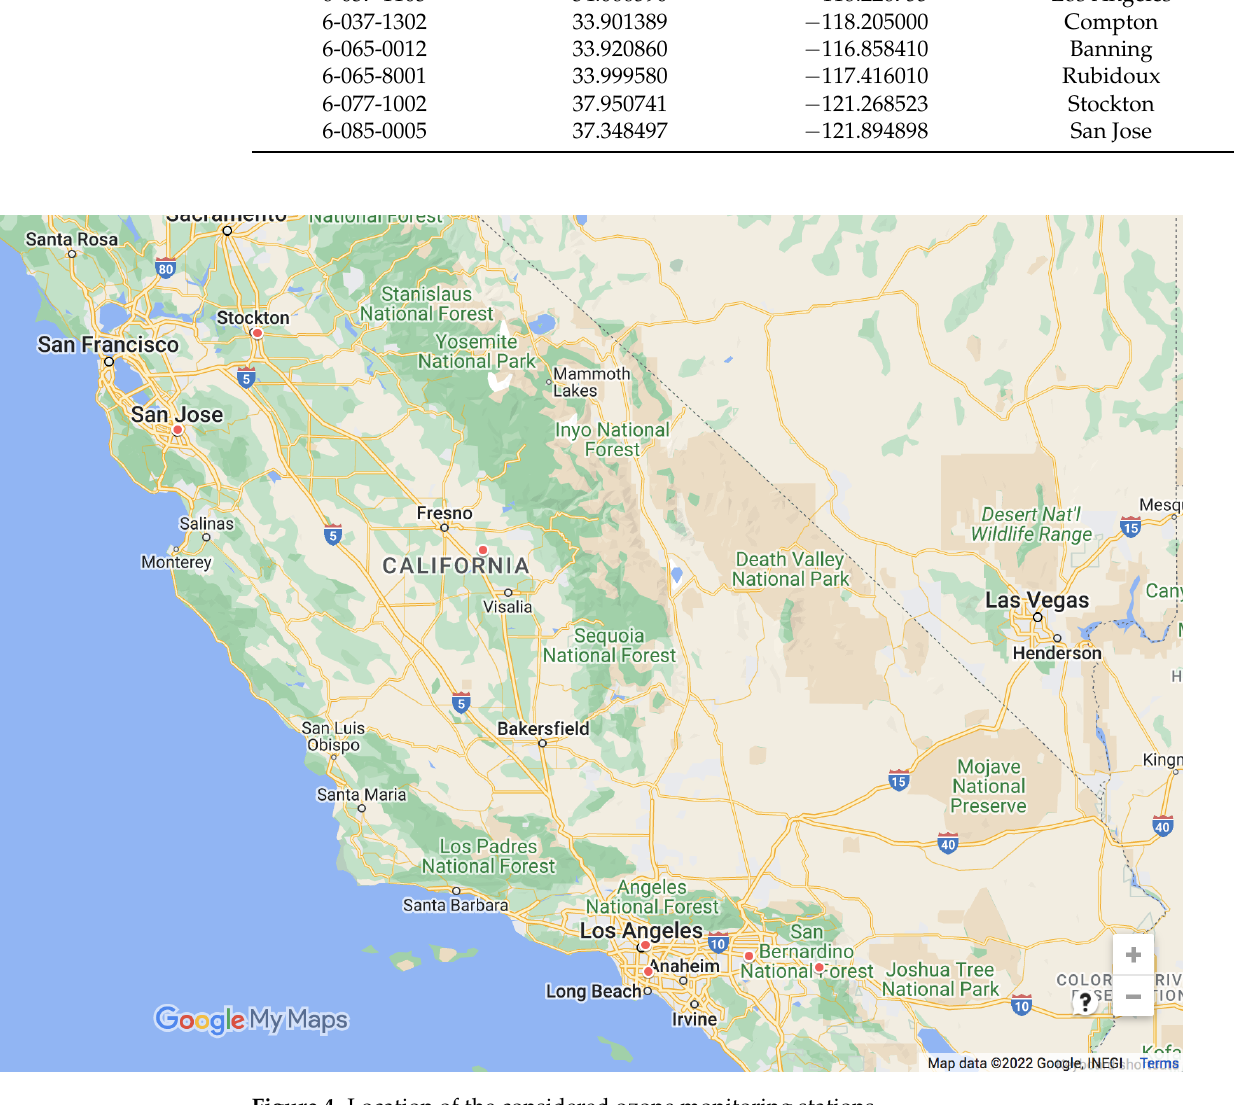
Figure 4. Location of the considered ozone monitoring